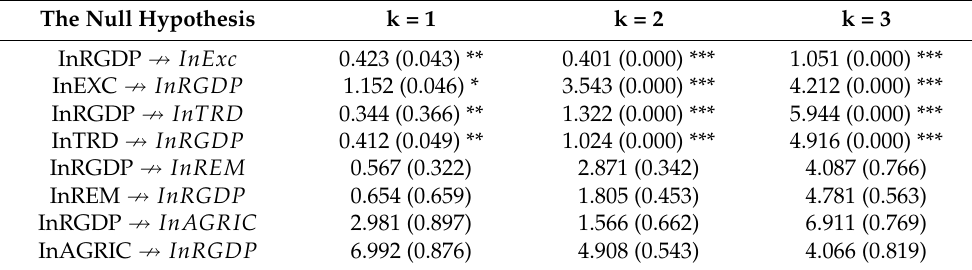
Table 2. Results of the Dumitrescu–Hurlin panel causality test.